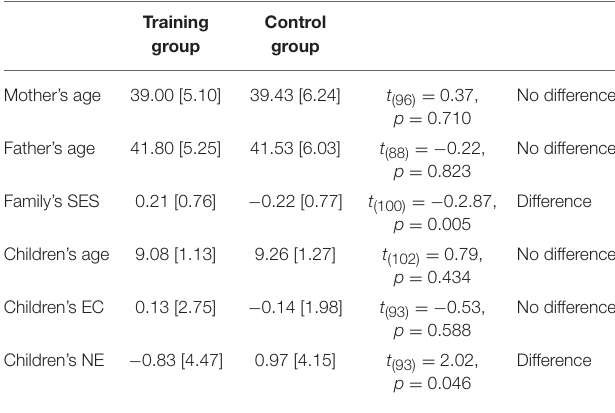
TABLE 1 | Training and control groups’ means, standard deviations and comparison of families’ socio-demographic characteristics and children’s temperament at